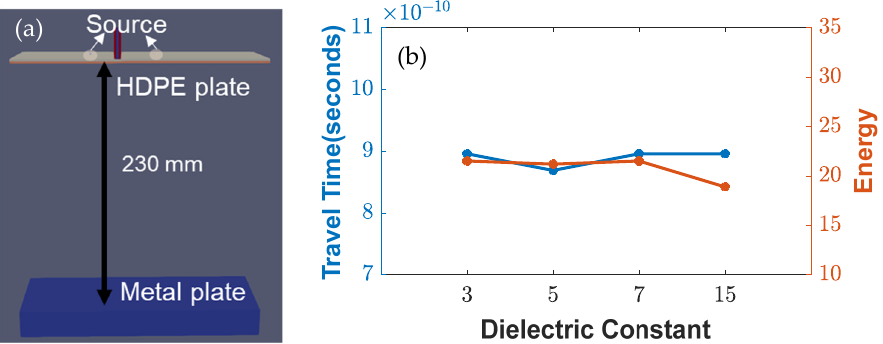
Figure 4. Simulation setup (from ( a – c )) for various heights from 230 to 244 mm. ( d ) Wave responses for variable heights, and ( e ) parametric study of various heights with increasing travel time and similar energy.